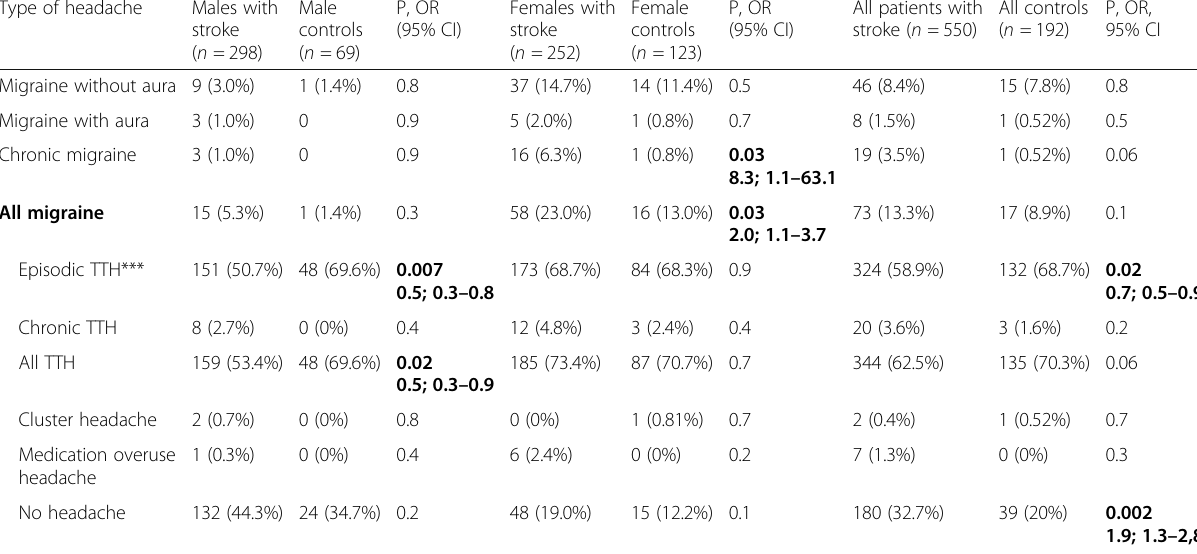
Table 3 The prevalence of headache disorders in patients ( n = 550) during the year before stroke (excepting last week before stroke) and during the last year before interview in controls (excepting last week before interview) ( n = 192) according to